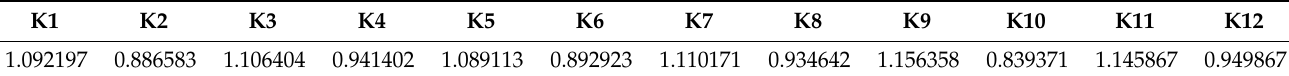
Table 1. Calibration of the low-cost magnetic encoder correction coefficients.